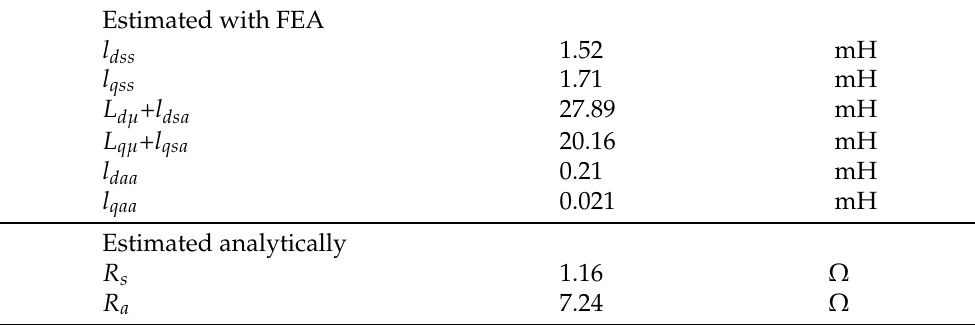
Table 1. Equivalent electrical circuit parameters, T = 50 °C, no